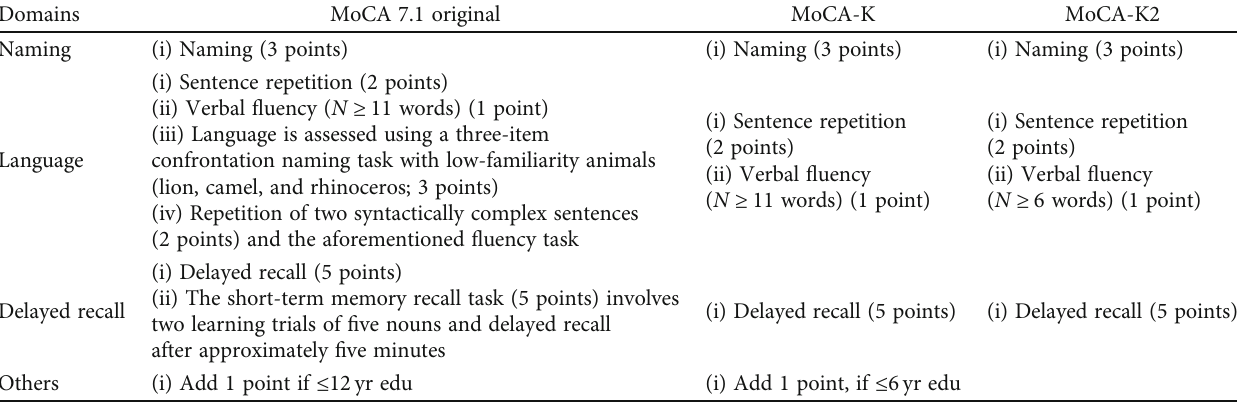
Table 1: Di ff erent items among MoCA, MoCA-K2, and